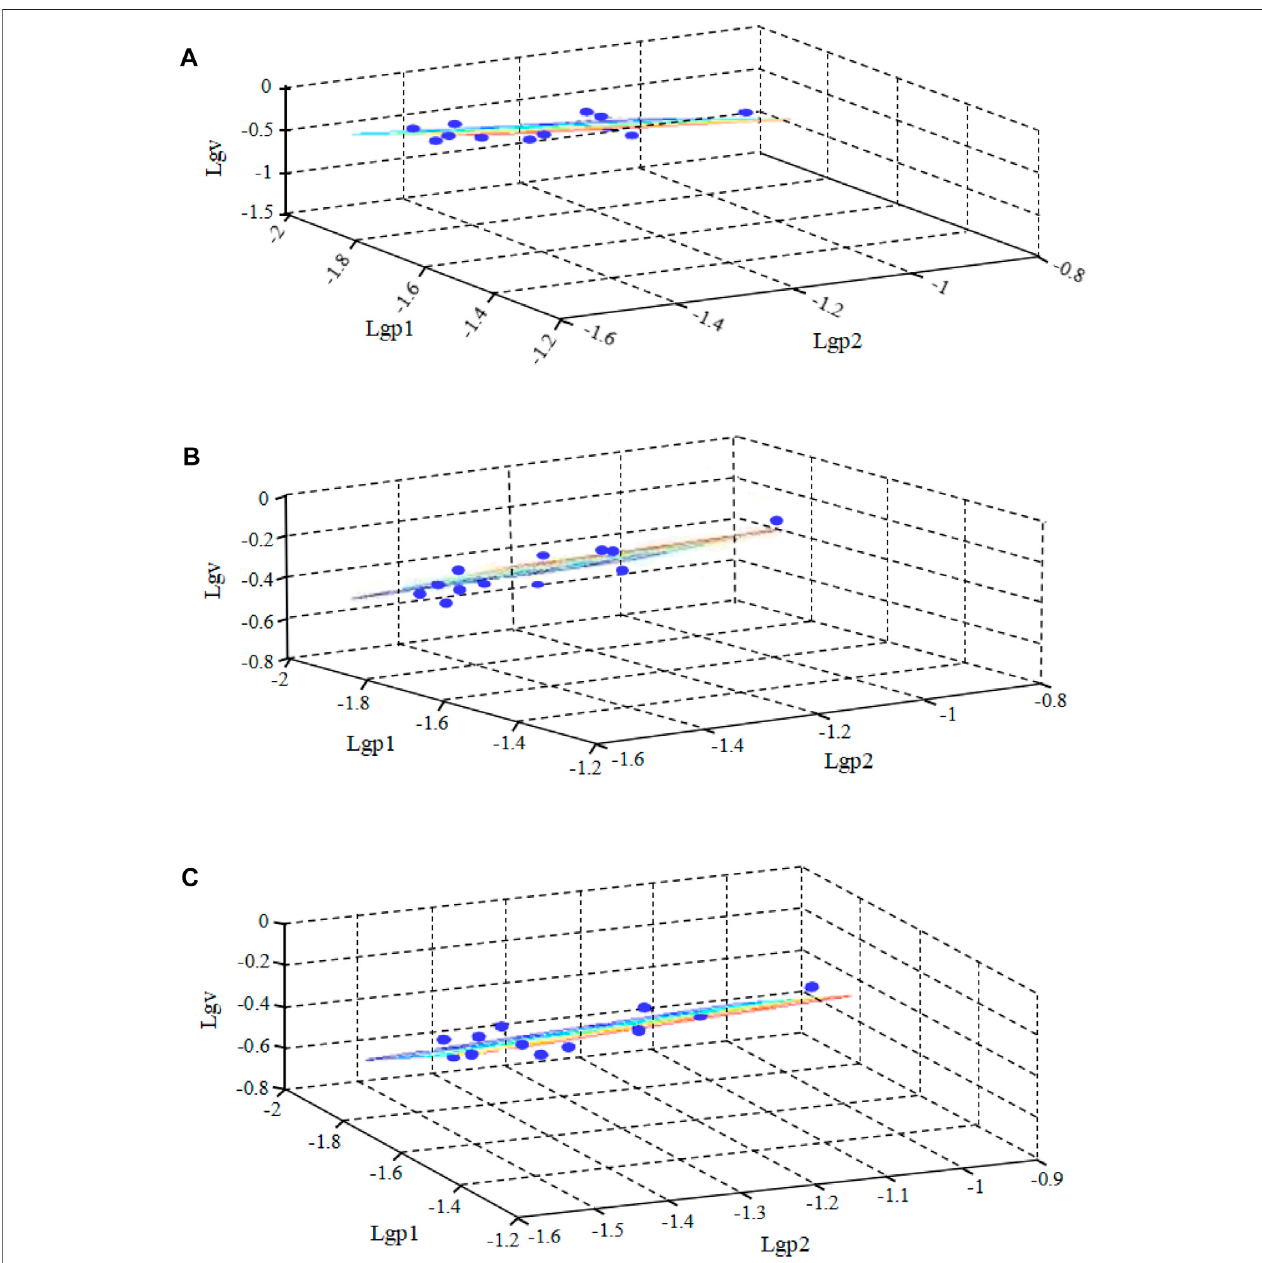
FIGURE11| Regressionanalysisresultsofvibration dataofdifferentcoordinate axes. (A) X -axisvibration dataregressionanalysisresults; (B) Y -axis vibration data regression analysis results; (C) Z -axis vibration data regression analysis results.